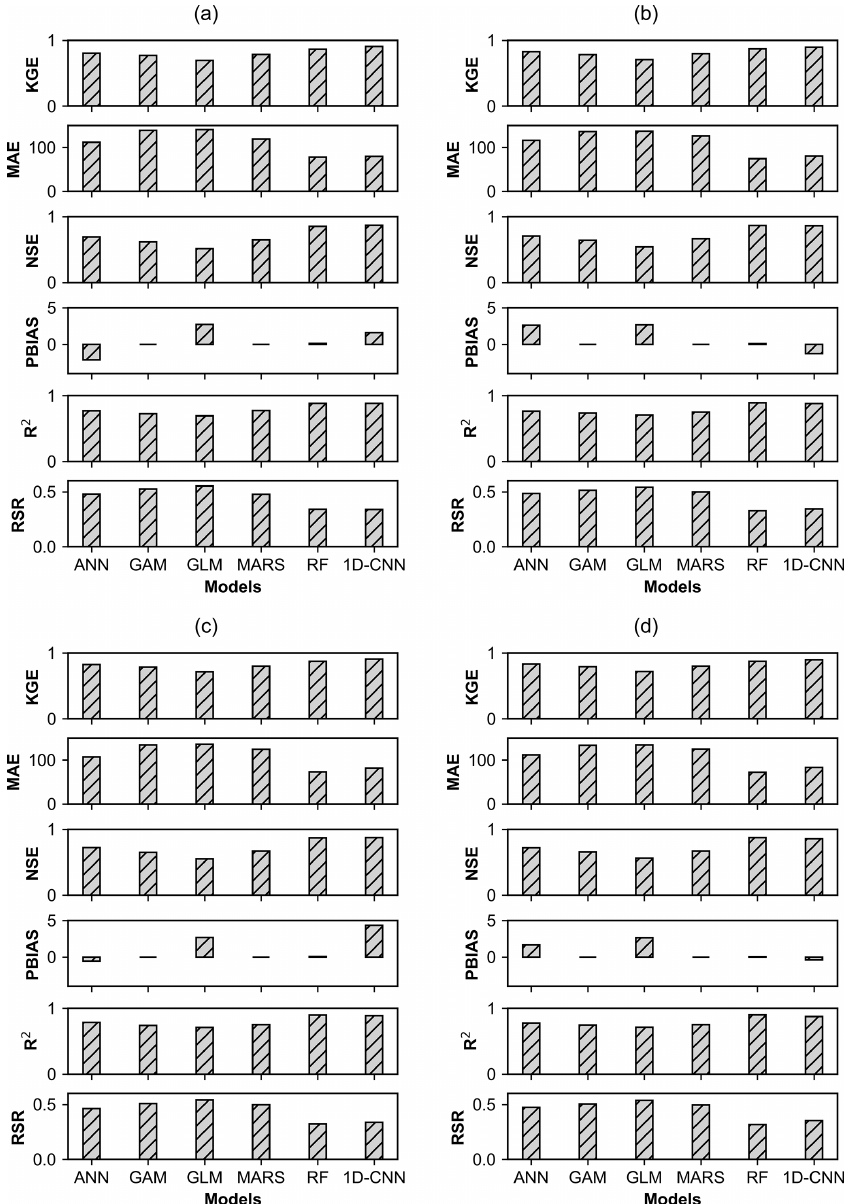
Figure 3. Evaluation of the models’ (ANN, GAM, GLM, MARSs, RF, and 1D-CNN) performance in simulating streamflow under rainfall scenarios (a) R 0 , (b) R 1 , (c) R 2 , and (d) R 3 at Kasol during the training phase using six statistical metrics ( R 2 , KGE, NSE, RSR, MAE, and